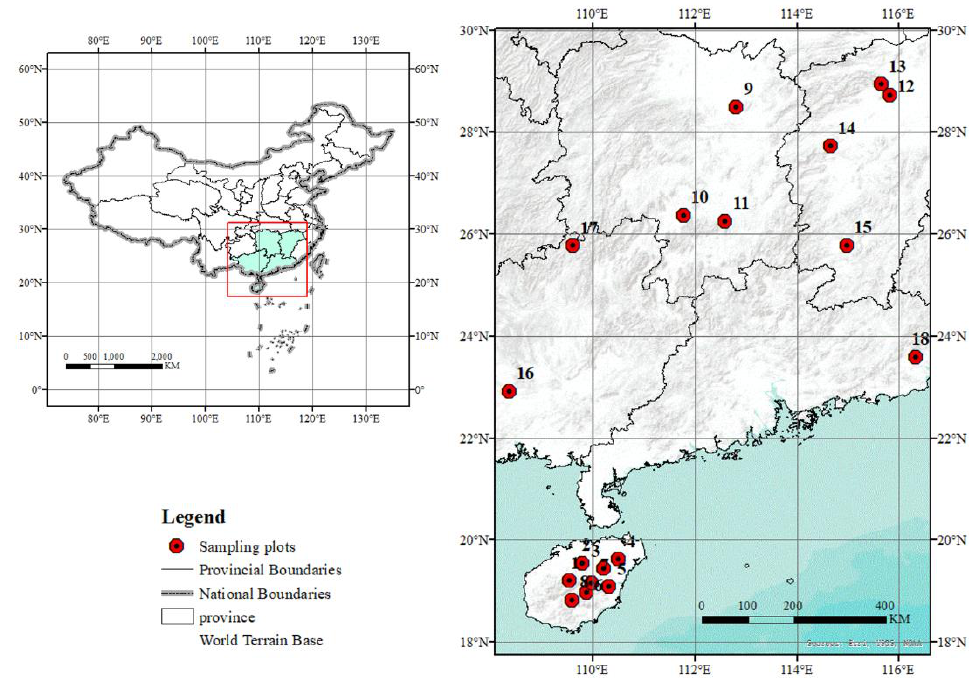
Figure 1. Location of the collected samples, covering the geographical distribution of Camellia oleifera in southern China. Table 1. The geographical and climatic variables of the 18 study sites of Camellia oleifera in south China.